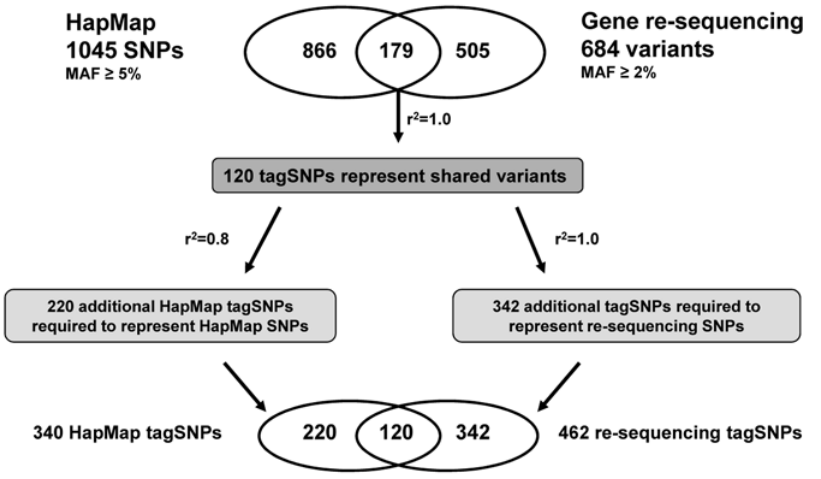
Figure 1. TagSNP selection strategy. HapMap genotypes for European individuals were obtained from the HapMap database. For each candidate gene, SNPs within the gene region 6 10 Kb were included. A MAF $ 5% and an r 2 =0.8 were used for tagSNPs selection using Haploview. Variants with a MAF $ 2% were analyzed in the gene re-sequencing set, with r 2 =1.0. Using a two-stage approach, we selected 682 tagSNPs that represent 1550 non-redundant variants from gene re-sequencing and HapMap data sets. tagSNPs (120) representing the 179 shared variants found in both data sets were determined in the gene re-sequencing set. CNS=conserved non-coding sequences.